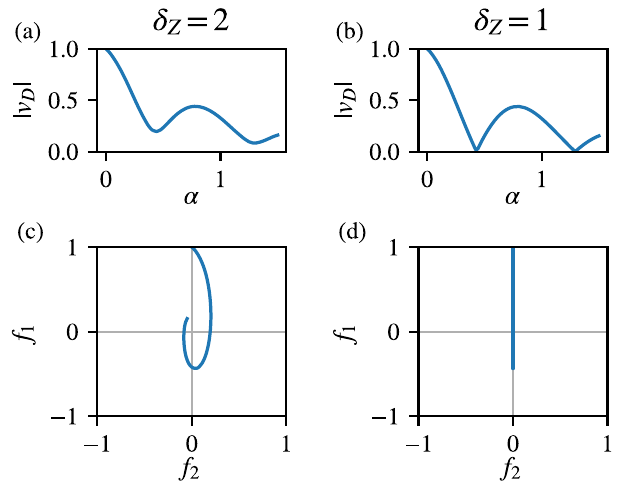
FIG. 1. The trajectory of ρ ð v (a) and (c) depict the trajectory of j v in Eq. (4)]. Since the trajectory in f 1 Dirac velocity does not vanish. Panels (b) and (d) are similar but 1 . The additional constraint on f with δ Z ¼ vanish on certain values of α